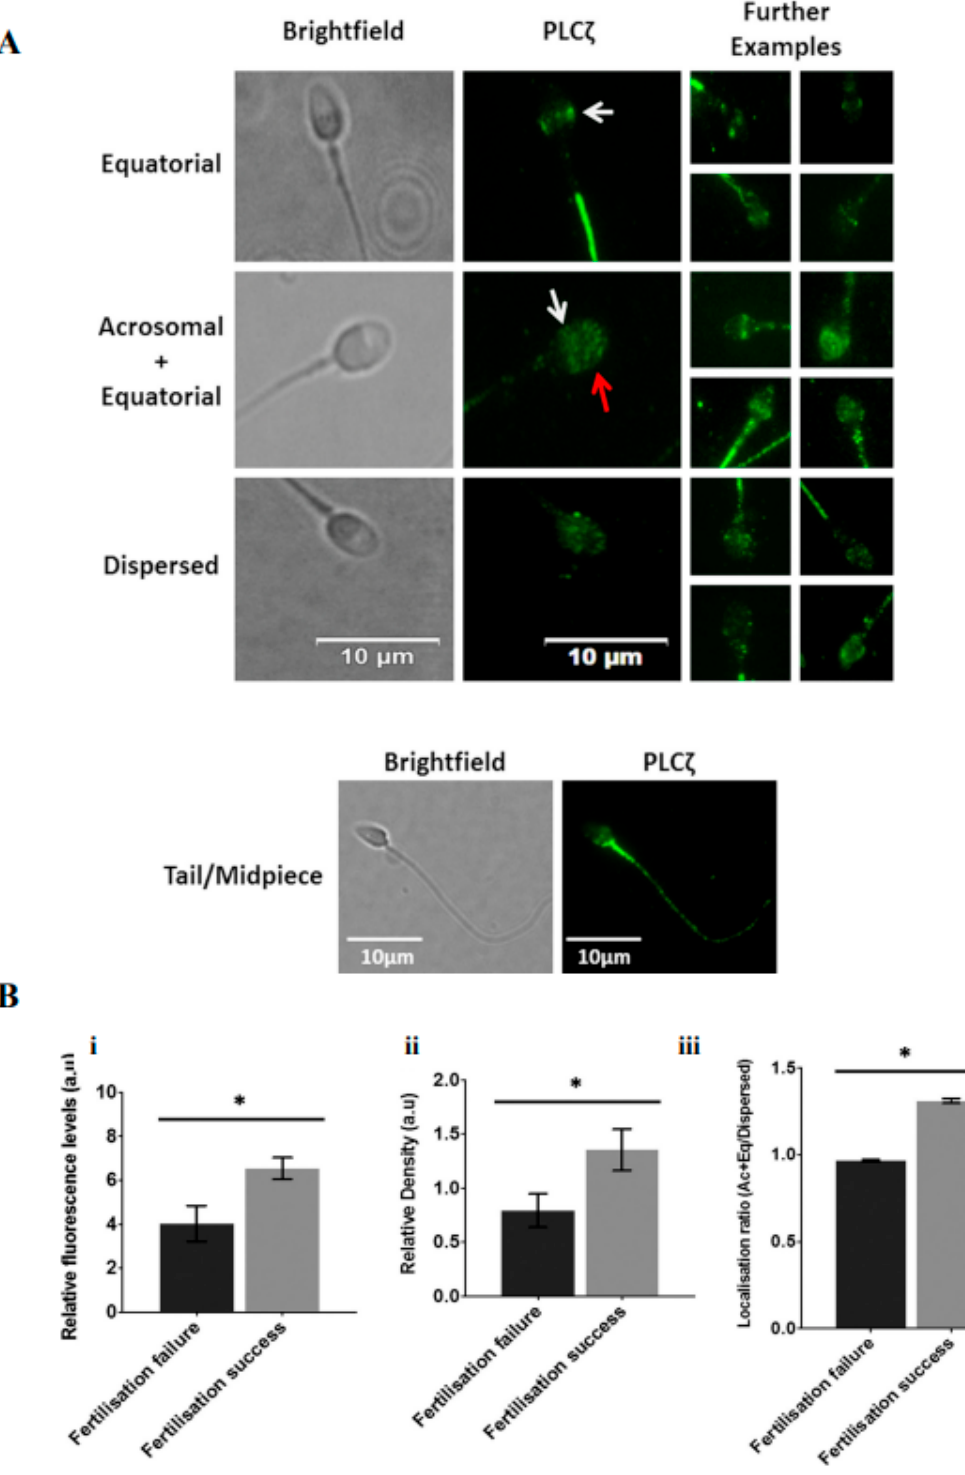
Figure 3. ( A ) Representative immunofluorescence images of observed PLC ζ localisation patterns in human spermatozoa. Brightfield (leftmost panels) and PLC ζ (green fluorescence; middle panel) images were obtained. Predominant localisation patterns observed include equatorial (white